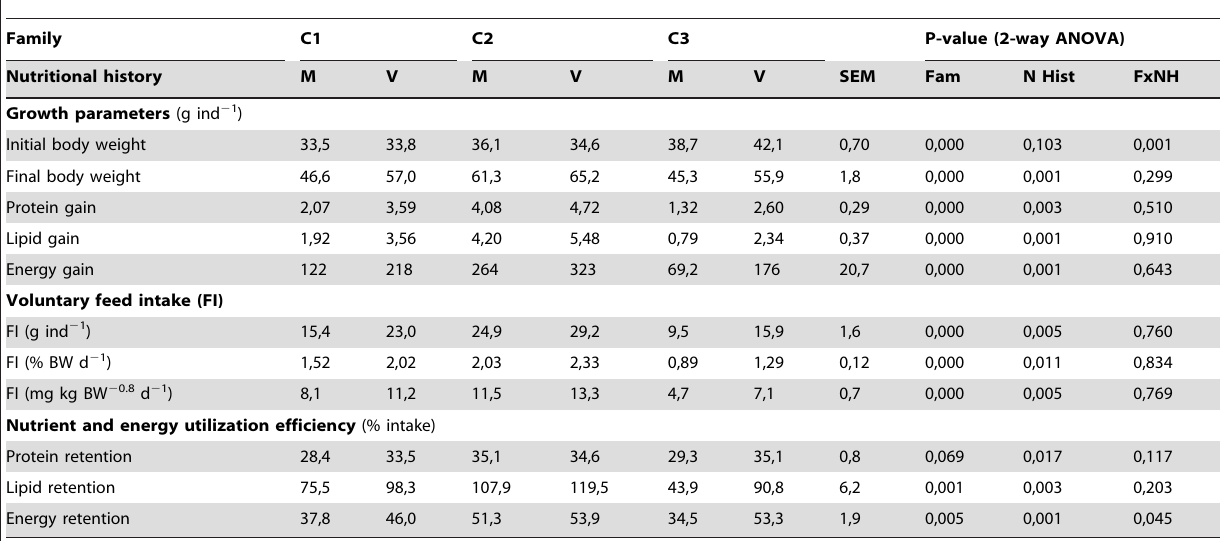
Table 3. Data on growth, feed intake and nutrient utilization of the trout during the 25-day V-challenge.